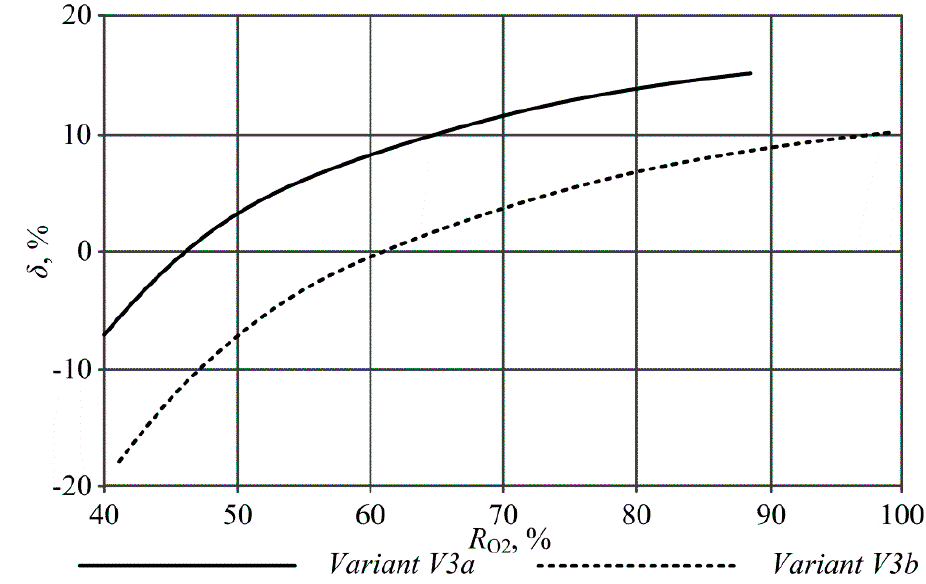
Figure 14. Oxy-type power plant auxiliary power rate as a function of the oxygen recovery rate.